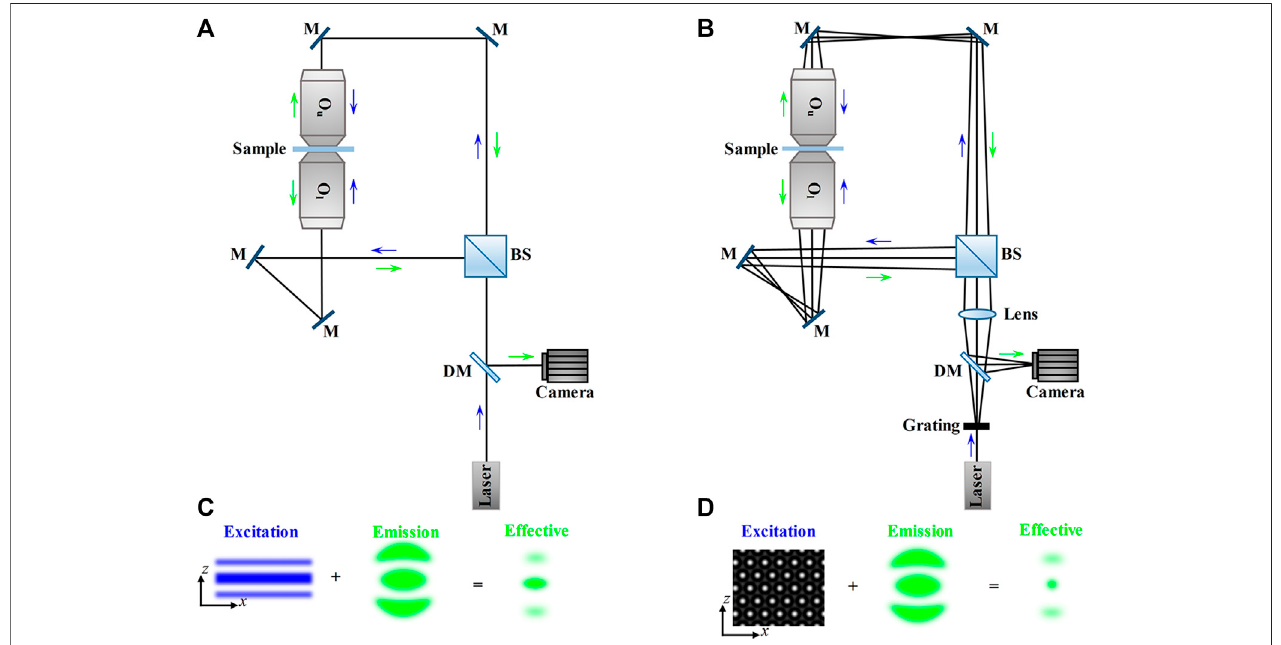
FIGURE4| SchematicandprincipleofI 5 MandI 5 S. (A) SchematicofI 5 M.Theexcitationbeamfromthelaserisfedthroughabeamsplitterandfourmirrorsintothe interference cavity. The fl uorescence emitted from the sample is inversely collected by the same objective lenses, re fl ected by adichroic mirror, and fi nally collected by a camera. (B) Schematic of I 5 S. The excitation beam from the laser is split by a grating into three diffracted beams, which is the only difference between I 5 S and I 5 M. (C) PSFsinI 5 Mintheaxial(xz)plane.TheeffectivePSFisobtainedbythesuperpositionofexcitationPSFandemissionPSF. (D) TheexcitationpatternandPSFsinthe axial (xz) plane. The effective PSF is obtained by the superimposition of the 3D interference pattern produced by the three diffracted beams and the emission PSF. Blue and green arrows indicate the directions of the excitation beam and fl uorescence. DM, dichroic mirror; SM, scanning mirror; BS, 50/50 beam splitter; M, mirror; Ou, the upper objective lens; O l , the lower objective lens.